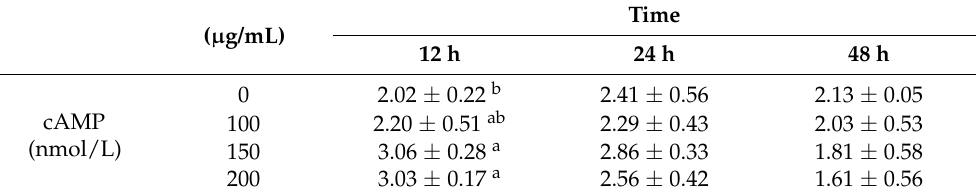
Table 6. Effect of different concentrations of GSP on cAMP levels in mature